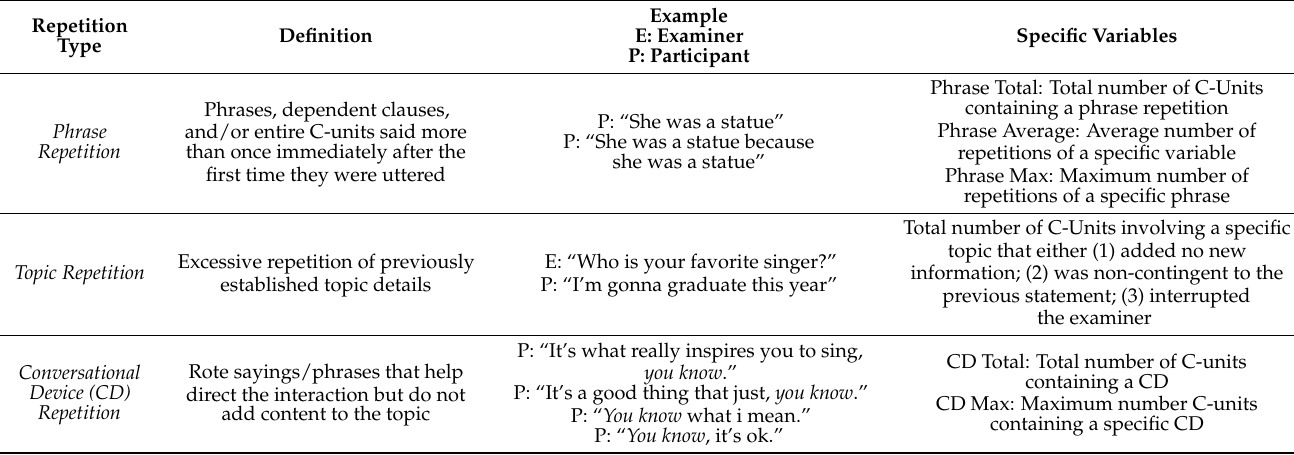
Table 2. Repetition Definitions and